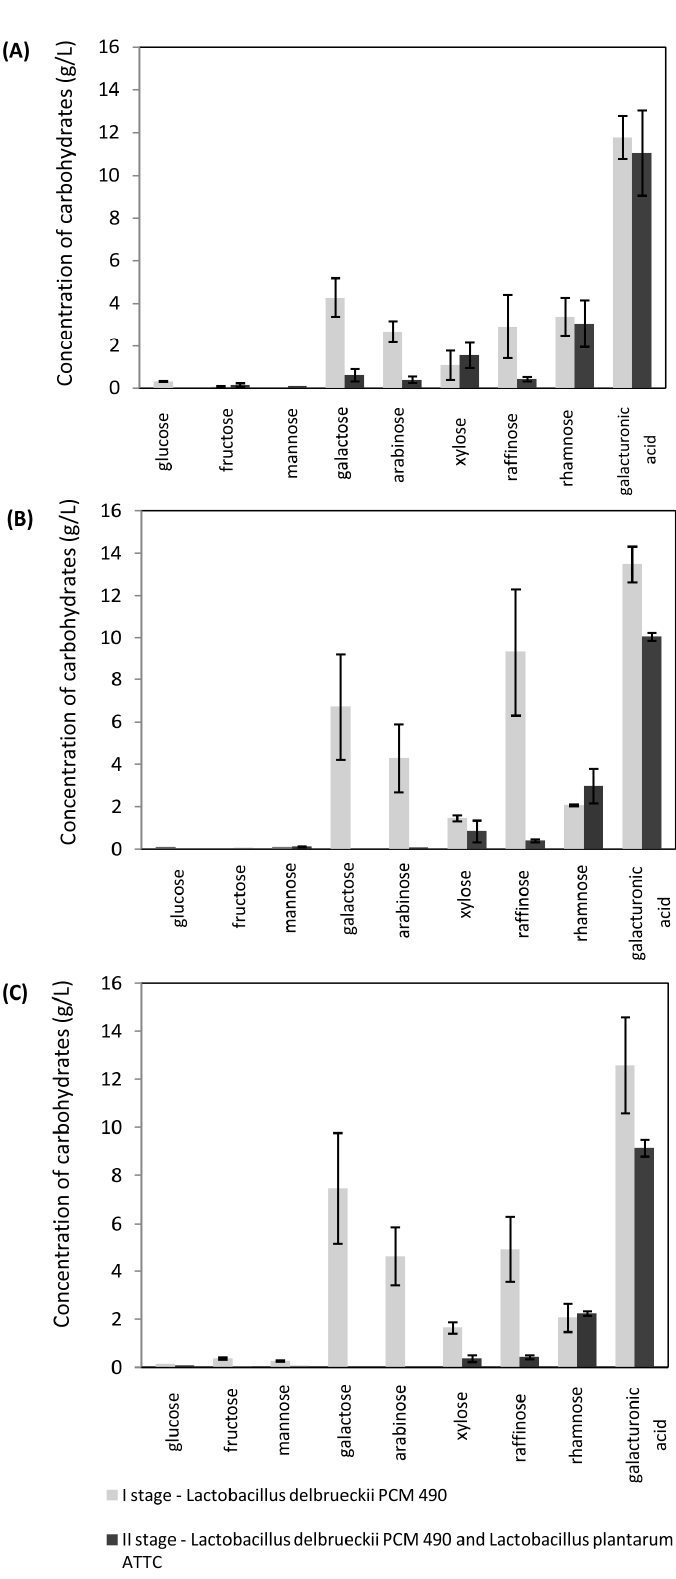
Figure 3. Concentration of carbohydrates (g/L) after ( A ) 4 h, ( B ) 10 h, and ( C ) 16 h of enzymatic pretreatment for I stage ( Lactobacillus delbrueckii PCM 490) and II stage ( Lactobacillus delbrueckii PCM 490 and Lactobacillus plantarum ATCC 8014).